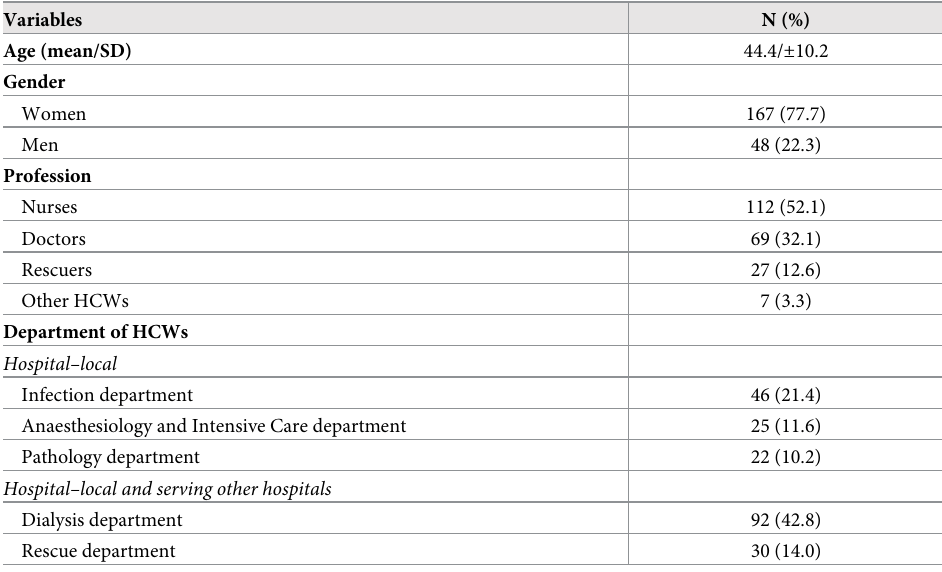
Table 1. Demographic characteristics of the respondents (Slovakia 2021; n = 215